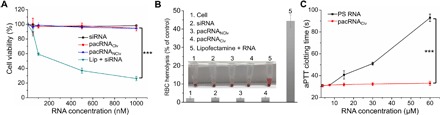
Cytotoxicity and blood compatibility of pacRNA.(A) Cell viability of SKOV3 cells treated with pacRNAs and controls. (B) Hemolysis of human blood (type O+) treated with pacRNAs and controls, as determined by spectrophotometric measurement of hemoglobin present in the supernatant of centrifuged RBC suspensions. The %RBC hemolysis is defined as the percentage of hemoglobin present in the supernatant compared with the total hemoglobin released by Triton X-100 treatment. Inset, photograph of centrifuged RBC suspensions. (C) Activated partial thromboplastin times of plasma treated with pacRNA or ss PS RNA at equal RNA concentrations. ***P < 0.001 (two-tailed t test).